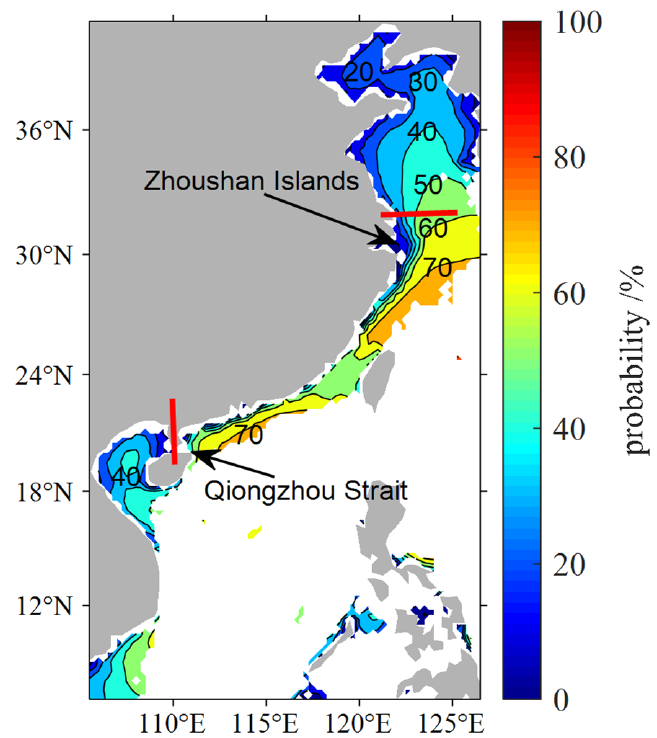
Figure 13. The probability distribution of wave height between 1 m to 4 m in the water depth less than 100 m.